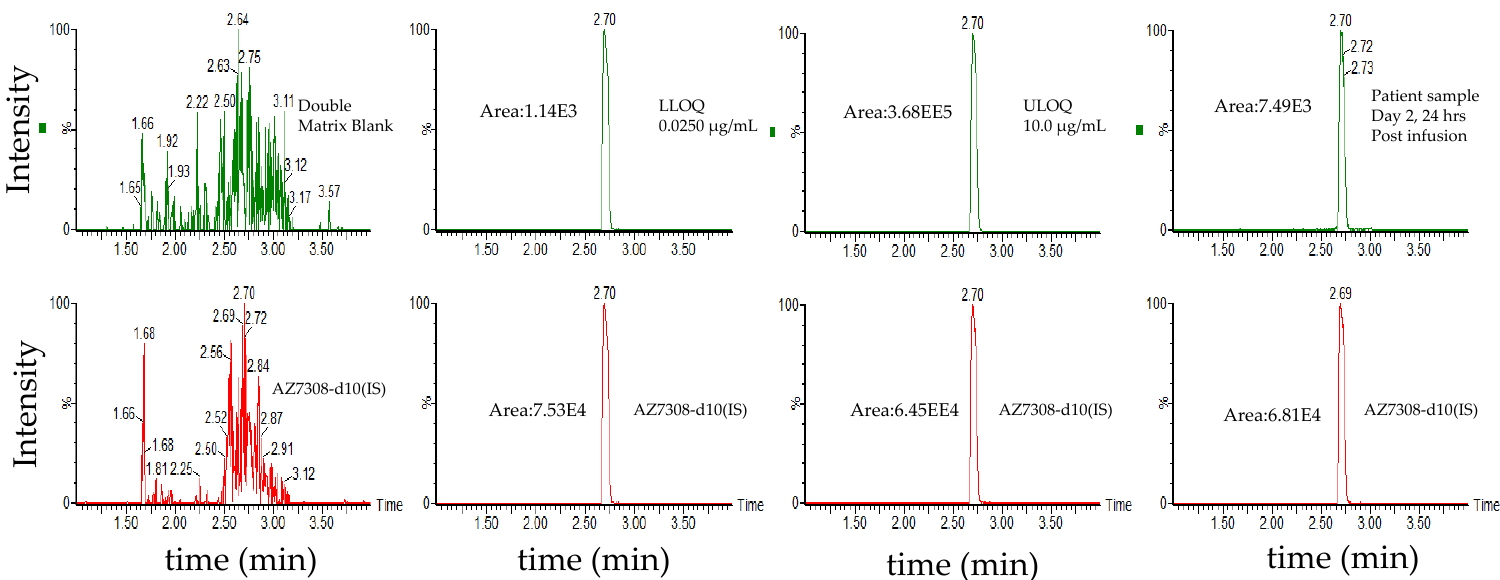
Figure 5. Representative chromatograms of total ADC (MEDI1498) using ac-AZ13687308 (AZ7308) as a surrogate analyte. Peak areas were quantified using Masslynx processing algorithm with a smoothing factor of